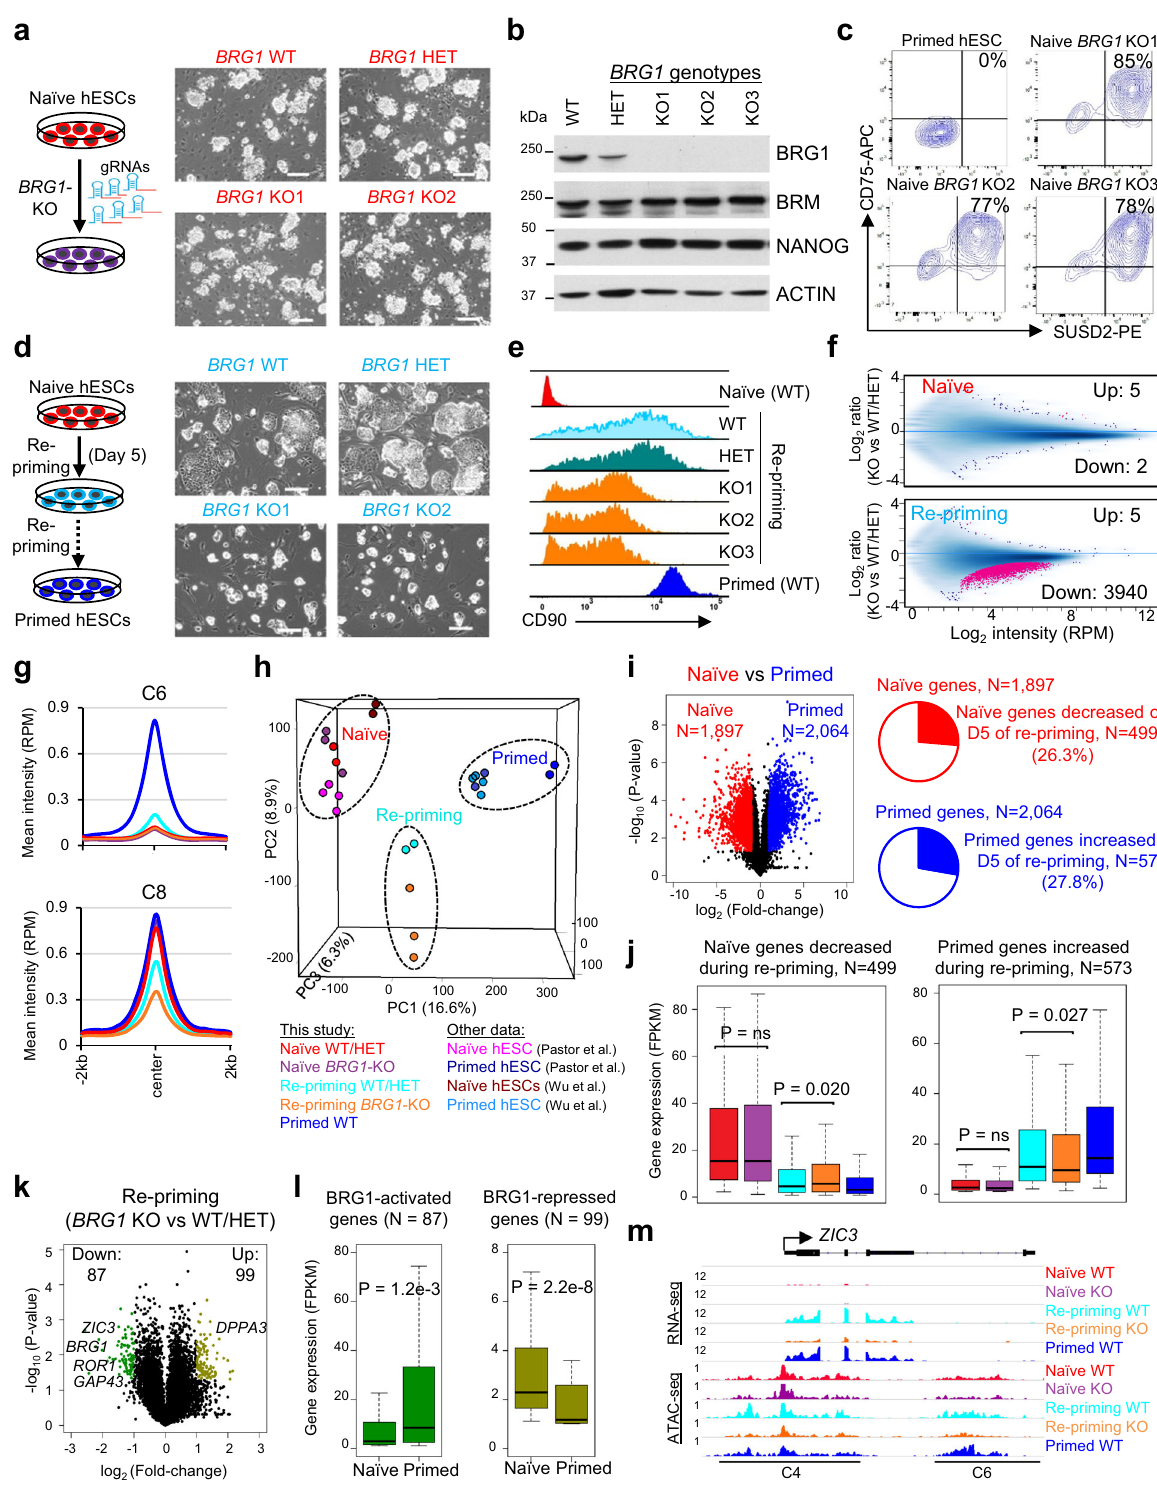
and 10 μ g fl uorescent FUW-Tomato vector with the same electroporation protocol. Two days later, Tomato-expressing cells were FACS-puri fi ed and replated at low density on MEF feeder layers. Individual colonies were picked and expanded 10 – 14 days after FACS sorting. The excision of the PGK-puro selection cassette was con fi rmed by Southern blot analysis. Southern blot . Genomic DNA was extracted from WIBR2, WIBR2-BirA, and WIBR2- OCT4 3x FLB io hESCs (before and after Cre excision of the